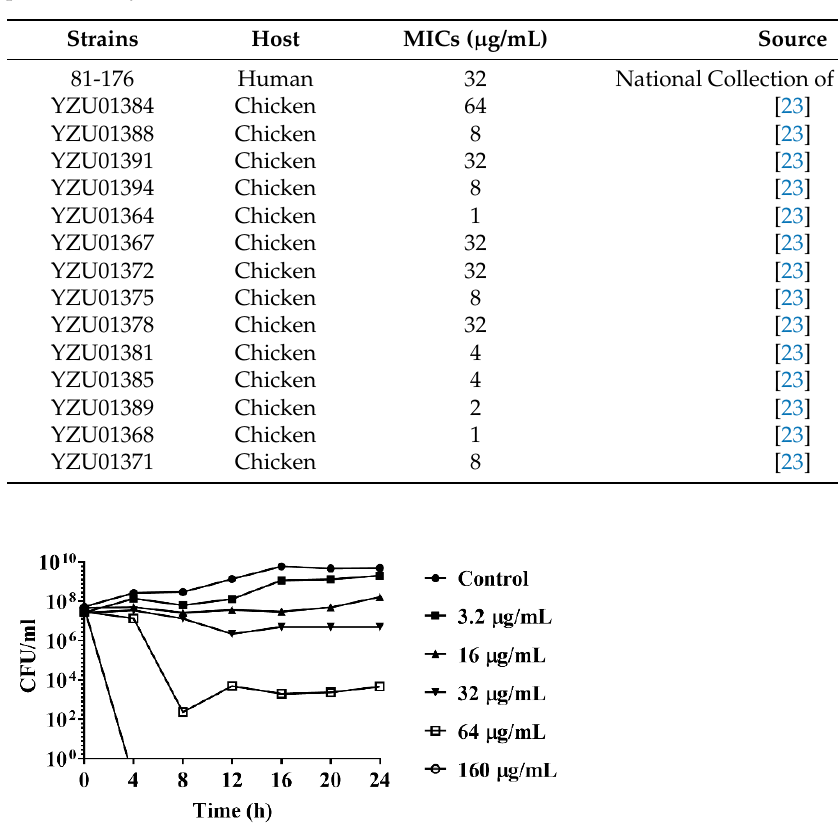
Table 1. Bacteria strains and minimal inhibitory concentrations of diallyl trisulfide (DATS) in the present study.